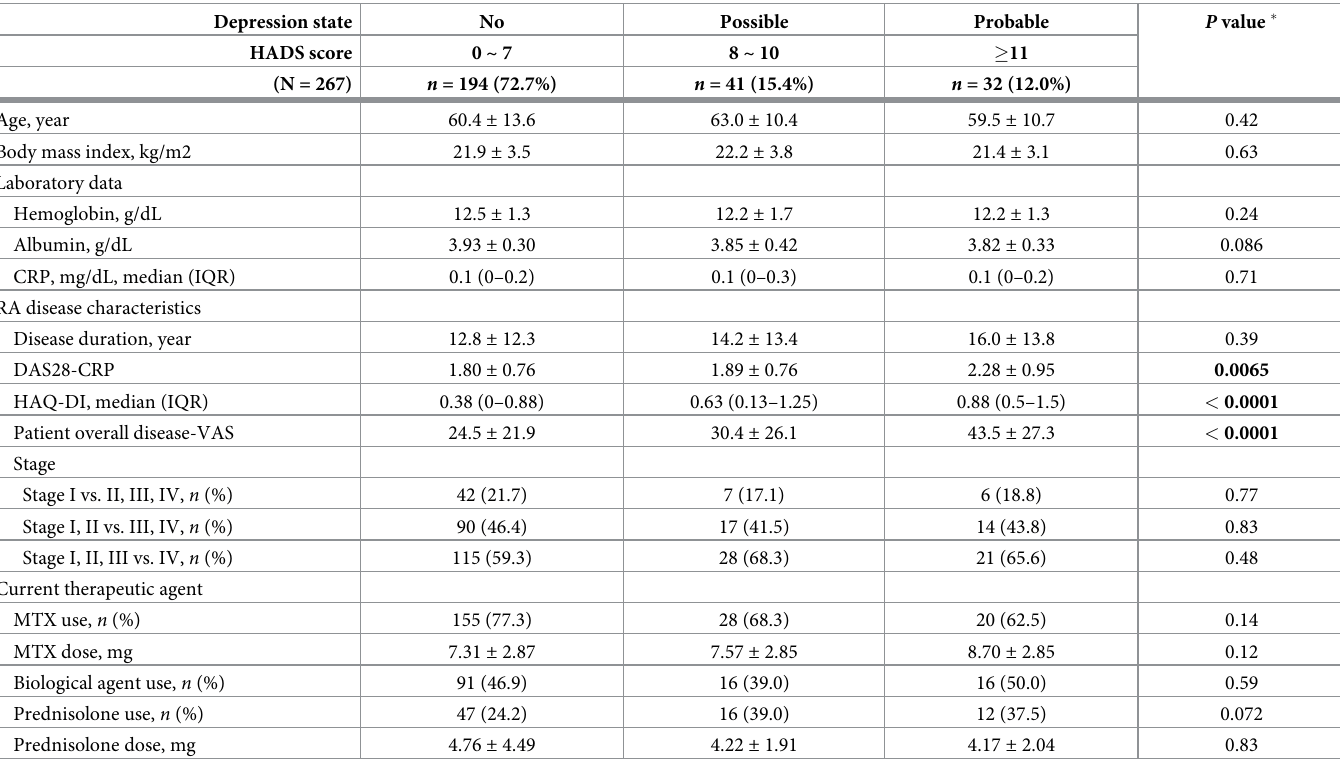
Table 2. Participants characteristics according to the depression state. Depression state No Possible Probable P value